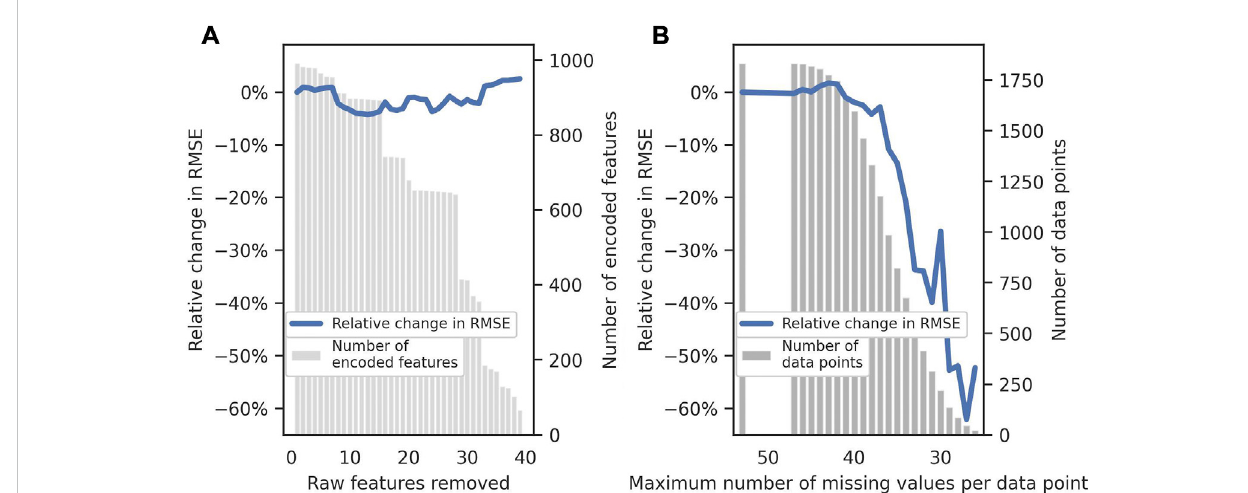
FIGURE 10 (A) Relative change in the extrapolated test RMSE when removing noisy features (the abscissa indicates the number of raw features removed from the67initialfeatures;eachrawfeaturemightcorrespondtomultipleencodedfeatures).ThebaselineistakenastheextrapolatedRMSEcomputedonthe complete dataset. The grey bars indicate how many encoded features are left in the dataset after removing the noisy ones. (B) Percent change in the extrapolated test RMSE when removing noisy data points. The baseline is taken as the extrapolated RMSE computed on the complete dataset. The grey bars indicate how many data points are left in the dataset after removing the noisy